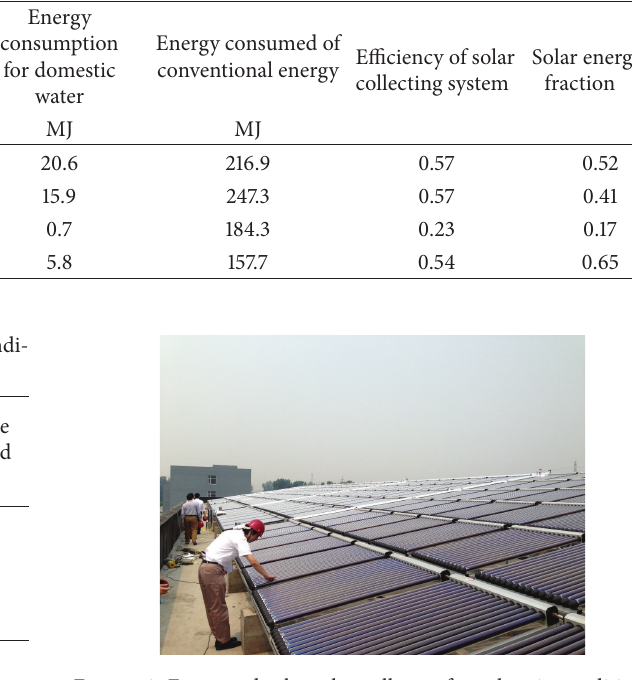
Table 10: Test results for a solar space heating system during heating conditions.